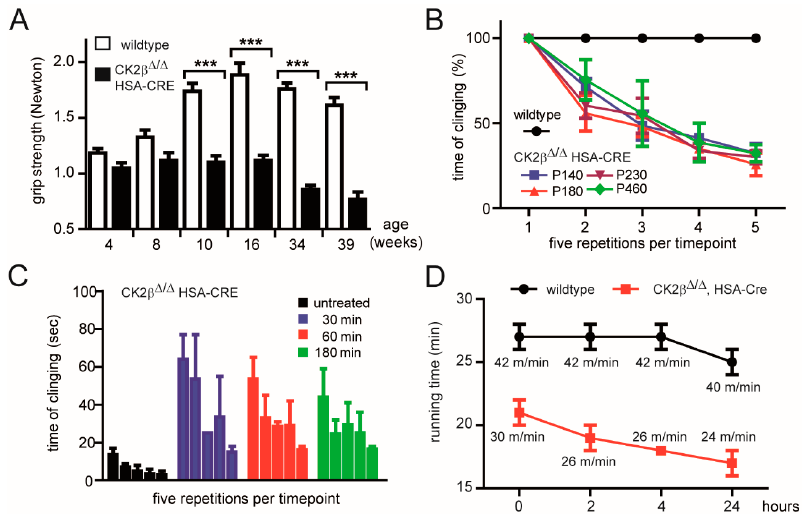
Figure 2. Grip strength of muscle-specific CK2 β -deficient mice. ( A ) Grip strength of >5 different pairs of mice (each mouse pair was composed of wild-type and mutant litters) of indicated age was measured by a grip-strength meter (Bio-GS3 Grip-Test, Bioseb Vitrolles, France). (*** p < 0.001; unpaired two-tailed Student’s t-test; n = >5 mice, each genotype). Error bars indicate s.e.m ( B ) Muscle grip strength was determined five consecutive times by measuring the time mice were able to cling upside-down on a grid until they fell down. Mice were then immediately put back on the grid, and the drop time was measured again. The first maximal clinging time measurement was set to 100%. The next four maximal clinging times decreased continuously. Different colors symbolize different mouse ages of CK2 β -deficient mice. As indicated, 140 up to 480 days old mice were analyzed. ( C ) Muscle grip strength was measured after administration of acetylcholine esterase inhibitor (neostigmine) to CK2 β -deficient mice (tail vein injection). After indicated times, maximal upside-down clinging time was measured and plotted to the number of repetitions. Note that wild-type mice were able to cling up to 10 min upside-down on a grid, while mutant mice after neostigmine injection were only able to cling upside-down for about 50 s. ( D ) Endurance capacity of aged-matched wild- type and mutant mice (8–10 months of age) was determined by enforced running on a treadmill. Note that mutant mice were exhausted at lower treadmill speed.